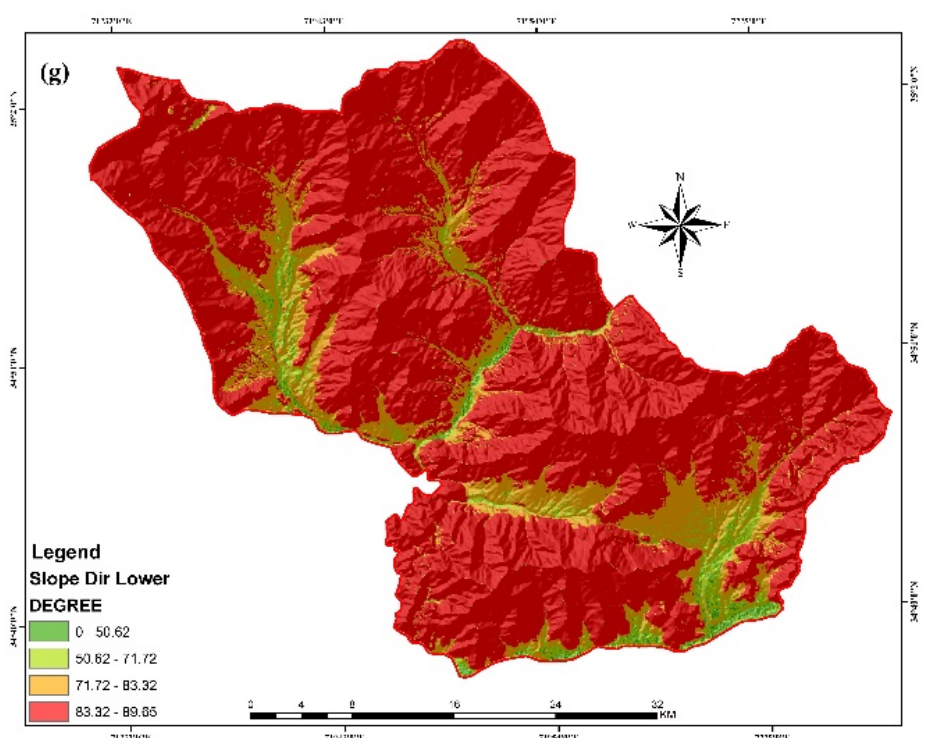
Figure 5. The thematic maps of (MIF) used for Identification of groundwater potential zones in Lower Dir: ( a ) geology; ( b ) drainage density; ( c ) rainfall; ( d ) lineament density; ( e ) land cover; ( f ) soil type; and ( g ) slope.